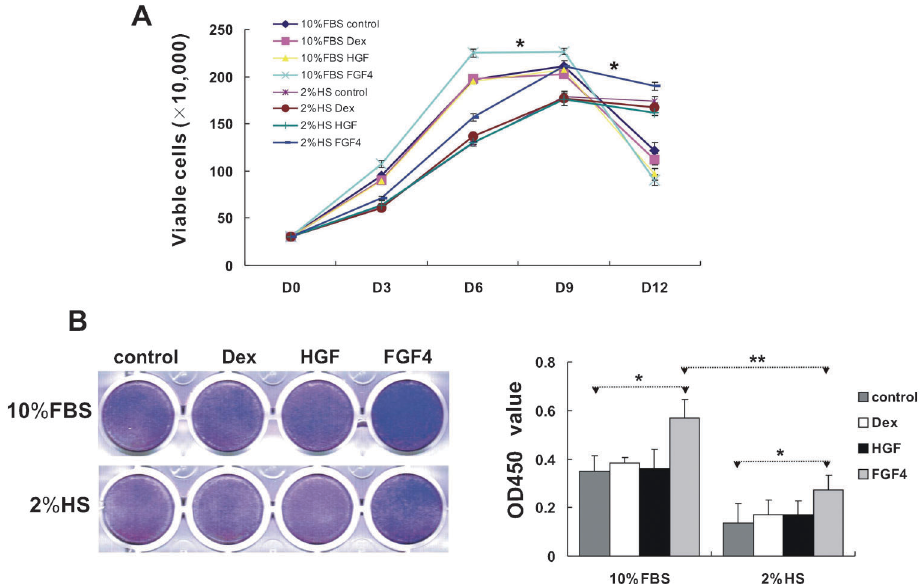
Figure 2. Cell proliferation of the induced hepatic progenitor cells (HPCs). Cells were plated onto 24-well plates at an initial density of 20,000/well, and treated with 0.1 m M Dex, 10 ng/mL HGF, 20 ng/mL FGF4 in 10% FBS or 2% HS. A , Cell proliferation was determined using trypan cell counting. *P , 0.05 FGF4 vs control; P , 0.05 2% HS vs 10% FBS; P . 0.05 control vs Dex or HGF (two-tailed Student t -tests). B , Crystal violet staining of HP14.5 cells at day 12 of induction. C , Absorbance of dissolved blue dye in each well in the same set of cells as in B . See Figure 1 for explanation of abbreviations. *P , 0.05 vs control; **P , 0.05 2%HS vs 10%FBS in same FGF4 treatment (two-tailed Student t